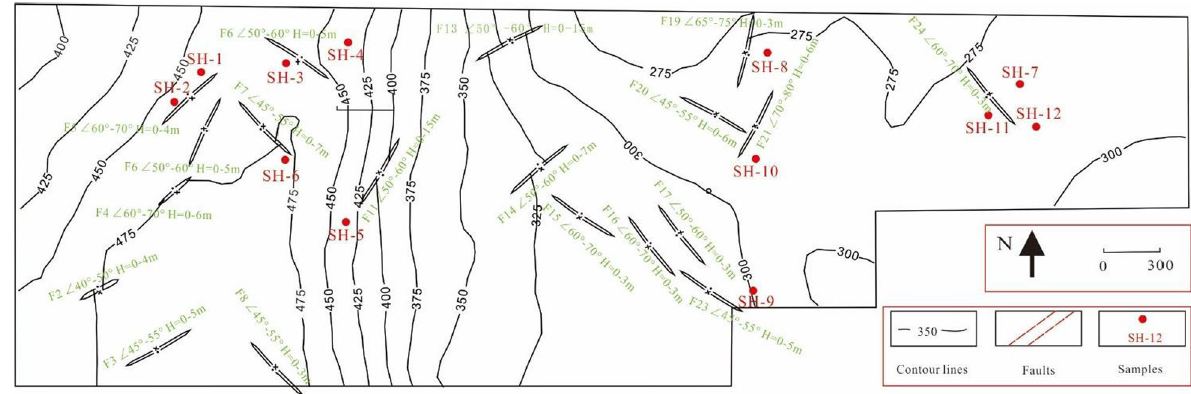
Fig. 1 Contour map of the floor of the No. 3 coal seam and distribution of sampling